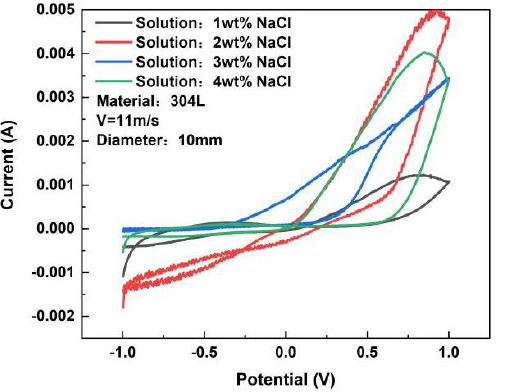
Figure 9. Cyclic voltametric curves of 304L stainless steel in NaCl solutions of different concentra- tions.